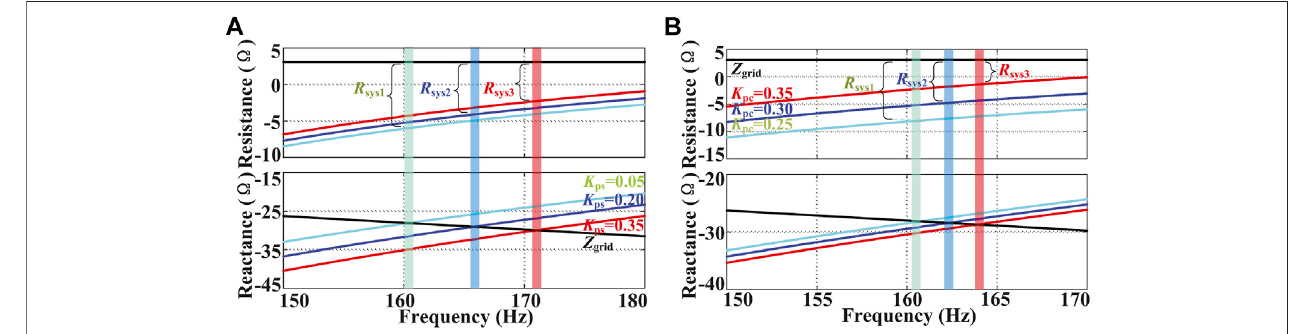
FIGURE 8 | Impact of different factors on Z vsc ( s ) and Z grid ( s ) . (A) K ps . (B) K pc